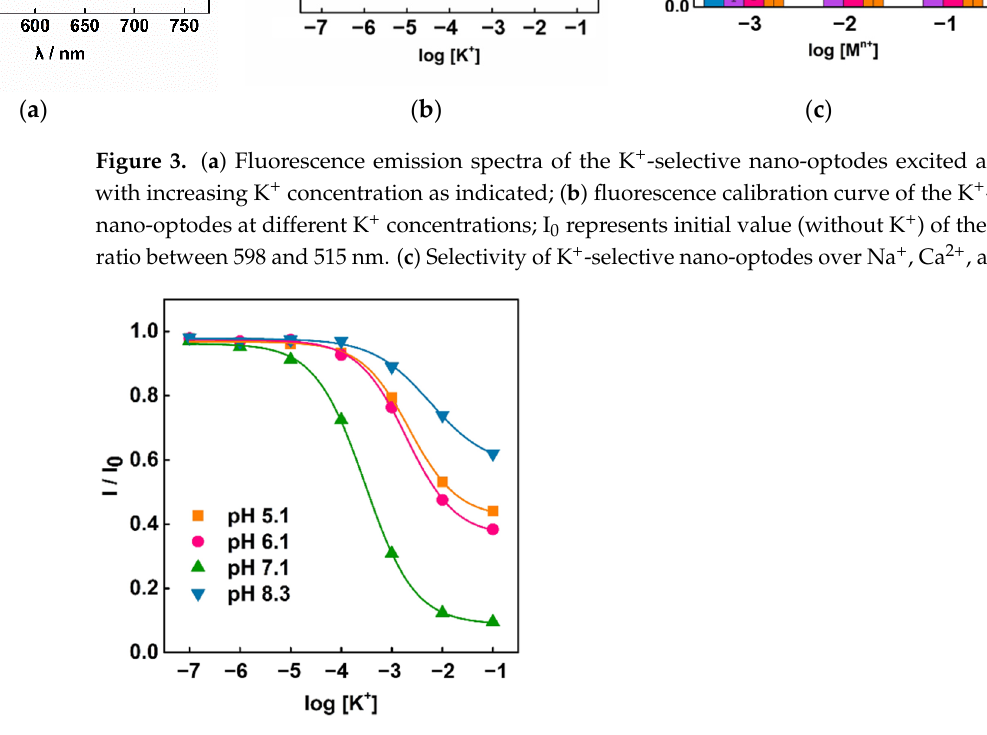
Figure 3. ( a ) Fluorescence emission spectra of the K + -selective nano-optodes excited at 480 nm with increasing K + concentration as indicated; ( b ) fluorescence calibration curve of the K + -selective nano- optodes at different K + concentrations; I 0 represents initial value (without K + ) of the intensity ratio between 598 and 515 nm. ( c ) Selectivity of K + -selective nano-optodes over Na + , Ca 2+ , and Mg 2+ .